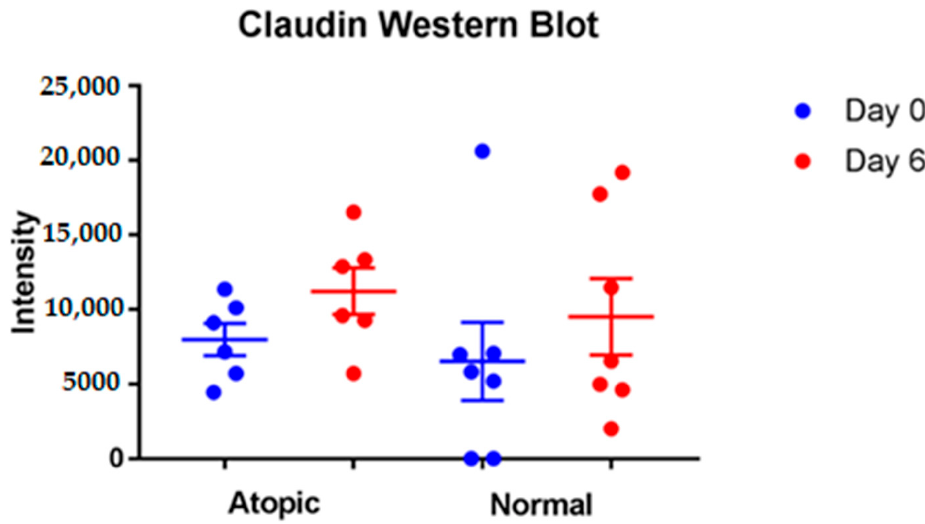
Figure 9. No significant differences for Claudin 1 were found overtime and between normal and atopic keratinocytes. For this analysis, seven normal and six atopic cell cultures were used.